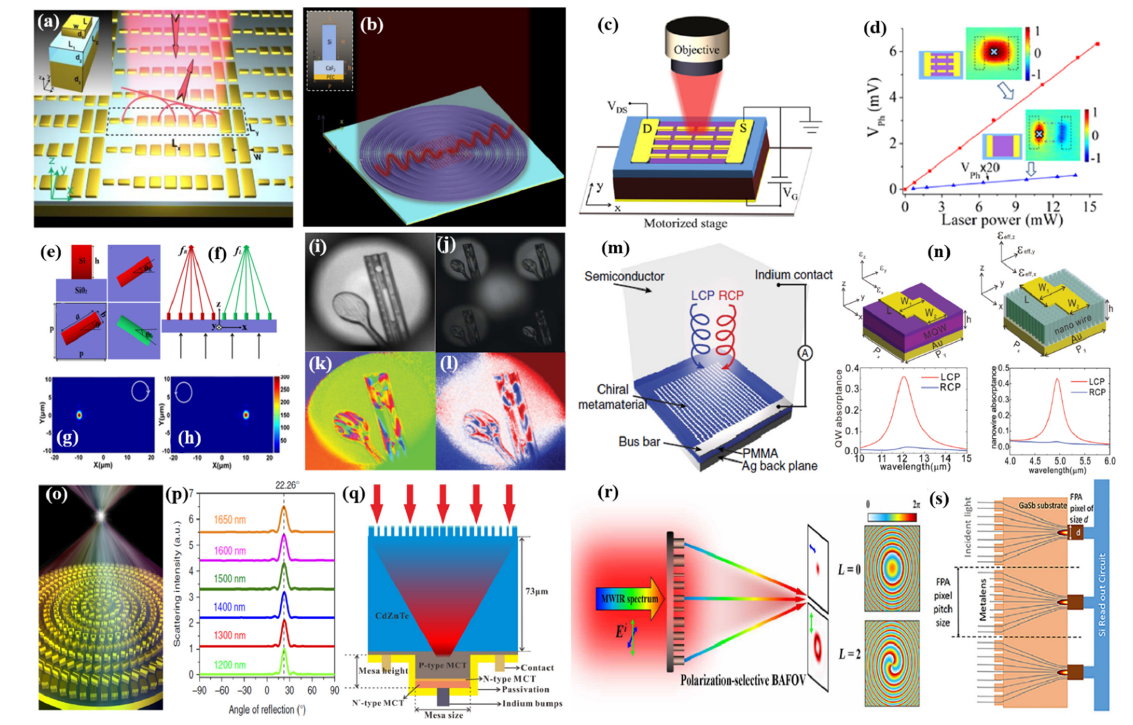
Figure 7. Metasurface-integrated infrared photodetectors. ( a ) Schematic of gradient metasurface. Reproduced with permission from Shulin Sun et al., Nano Letters; published by ACS, 2012 [147]. ( b ) Absorption enhancement of thin-layer black phosphorous with an all-dielectric gradient metasurface. Reproduced with permission from Nan Zhang et al., Optical Materials Express;